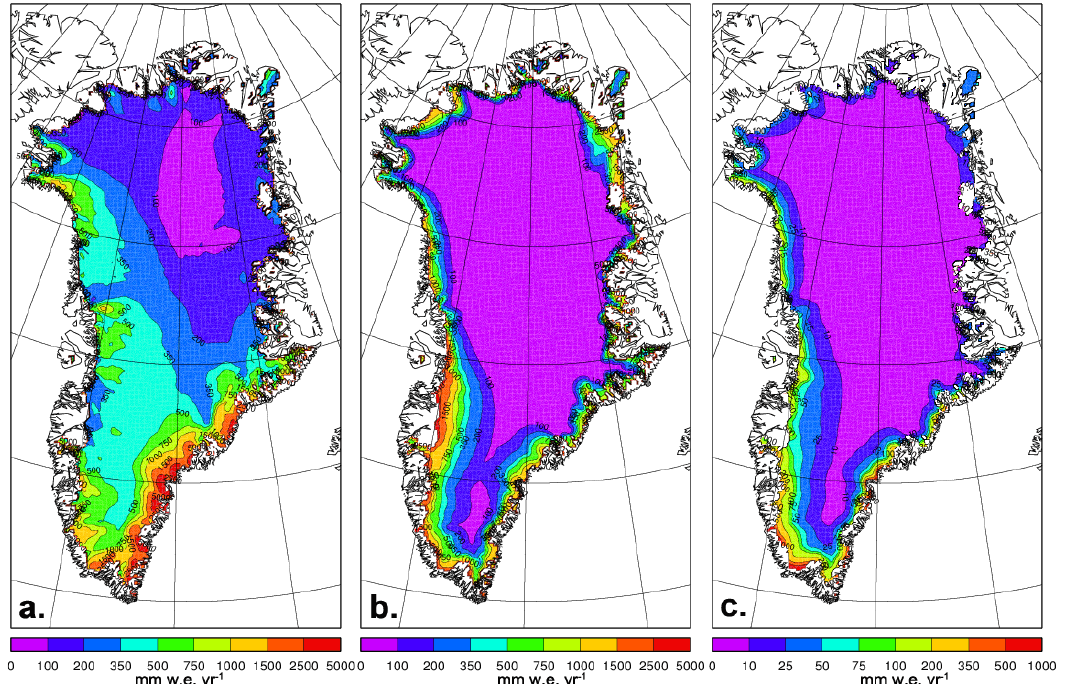
Fig. 3. Period (1958–2008) averaged anual sums of (a) snowfall ( C ) (b) melt ( M ), and (c) rain as modelled in RACMO2. Note the different scale in panel